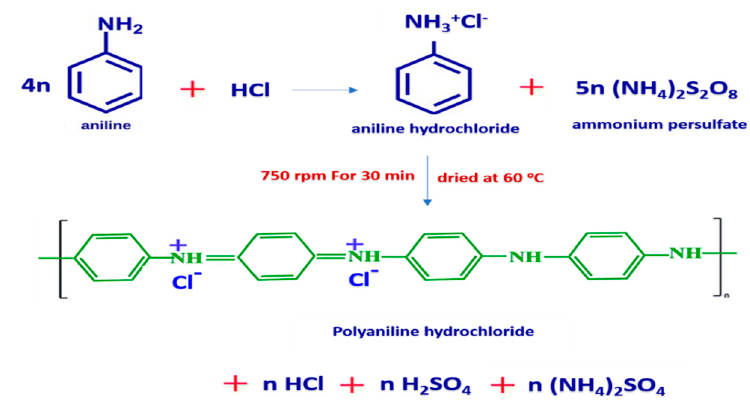
Figure 10. Polymerization of aniline hydrochloride to form polyaniline (emeraldine) hydrochloride.